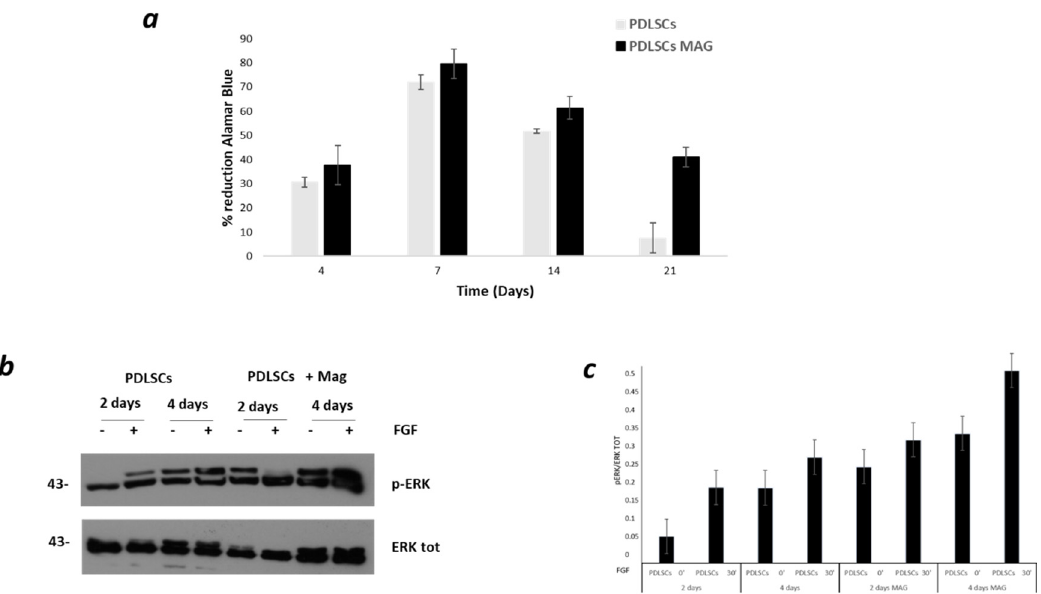
Figure 1. ( a ) Percentage of Alamar Blue reduction evaluated for PDLSCs and PDLSCs MAG at different time points. ( b ) Western blotting analyses performed on PDLSCs and PDLSCs MAG. The experimental groups were treated with fibroblast growth factor (FGF2) at indicated time points (0 and 30 min). ( c ) p-ERK normalized to the total amount of ERK for PDLSCs and PDLSCs MAG at 2 and 4 days.